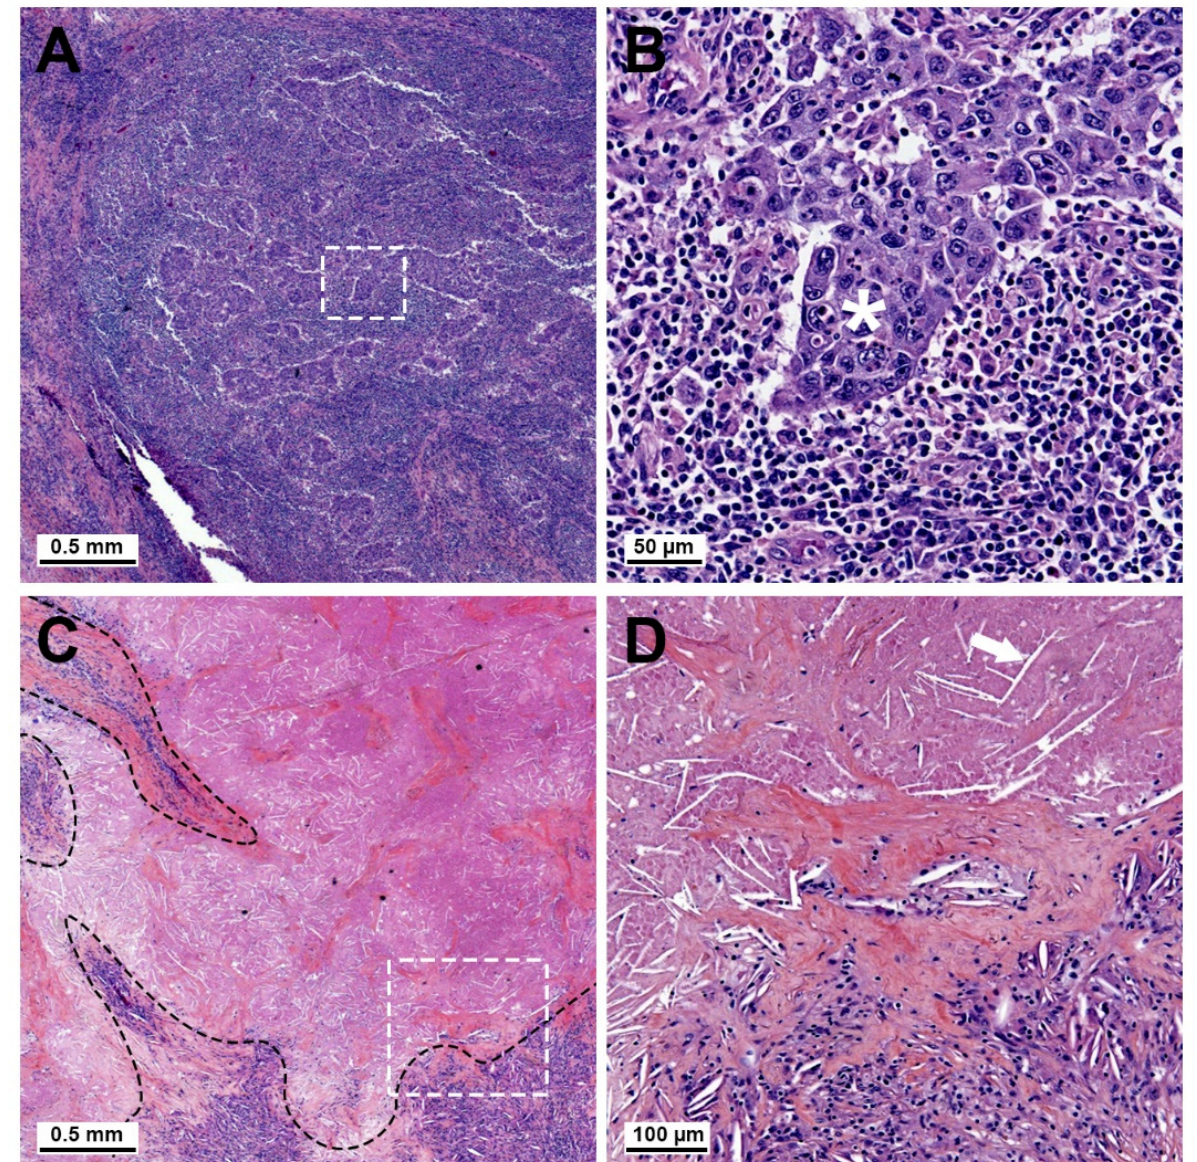
Figure 3. Representative slides for estimation of the residual tumor using hematoxylin and eosin staining in the ICI cohort. ( A ) Example of major pathological response (MPR) in one patient. Islets of residual viable tumor tissue are surrounded by a major inflammatory cellular infiltrate. White rectangle is magnified in ( B ) and shows a residual tumor islet with large atypical cells (white asterisk) surrounded by small mononucleated inflammatory cells. ( C ) Example of complete pathological response (pCR) in one patient, with zones of tissue fibrosis and inflammatory infiltrates (delineated in black) and large areas of tumor necrosis with no residual viable tumor. White rectangle is magnified in ( D ) and shows the demarcation between fibrotic, inflammatory tissue, and necrosis with cholesterol crystal imprints